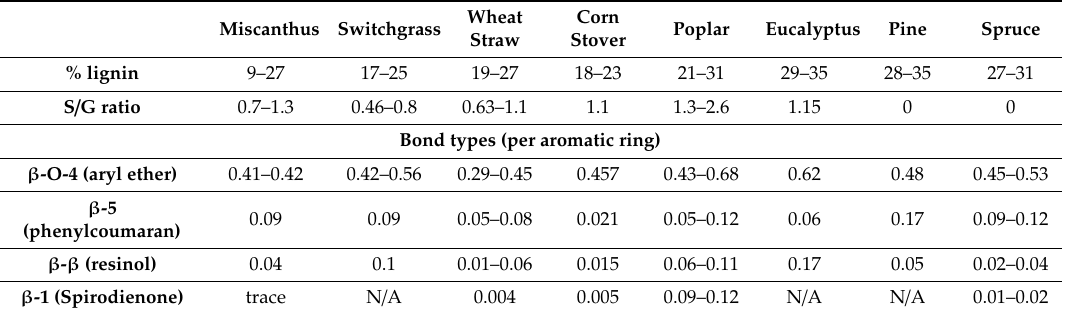
Table 1. Lignin content and major intermonomer bond types in several common bioenergy and agricultural plant biomass sources a